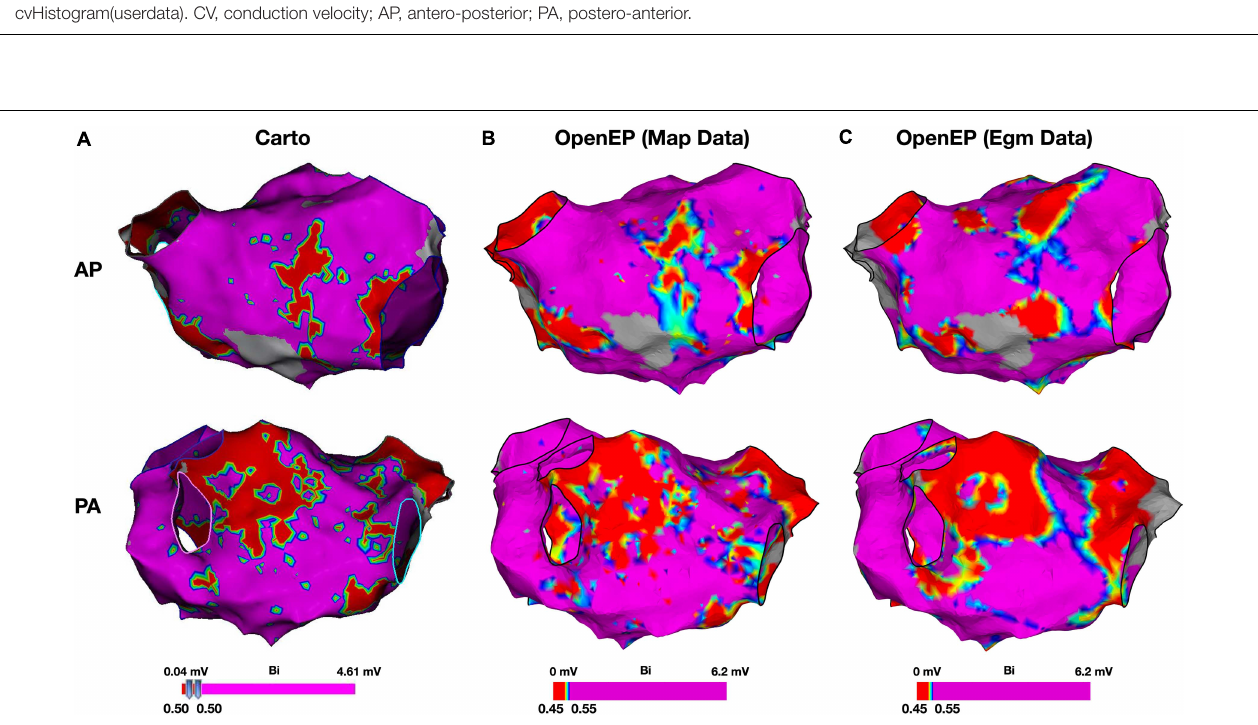
FIGURE 9 | Bipolar voltage mapping. (A) Voltage maps created using Carto, with a voltage threshold of 0.5 mV. (B) Voltage maps created using OpenEP with a voltage threshold range of 0.4–0.6 mV applied to the voltage mapping data exported by Carto. OpenEP command: drawMap(userdata, 'type', 'bip', 'coloraxis', [0.4 0.6], 'orientation', 'pa', 'colorfillthreshold', 10) ; (C) Voltage maps created using OpenEP with a voltage threshold range of 0.45–0.55 mV, interpolated from the raw electrogram data at every mapping point and with a color fill threshold of 10 mm. OpenEP command: interpBip = generateInterpData(userdata, 'bip-map'); drawMap(userdata, 'data', interpBip, 'type', 'bip', 'coloraxis', [0.4 0.6], 'orientation', 'pa') . AP, antero-posterior; PA, postero-anterior; Bi, bipolar voltage.